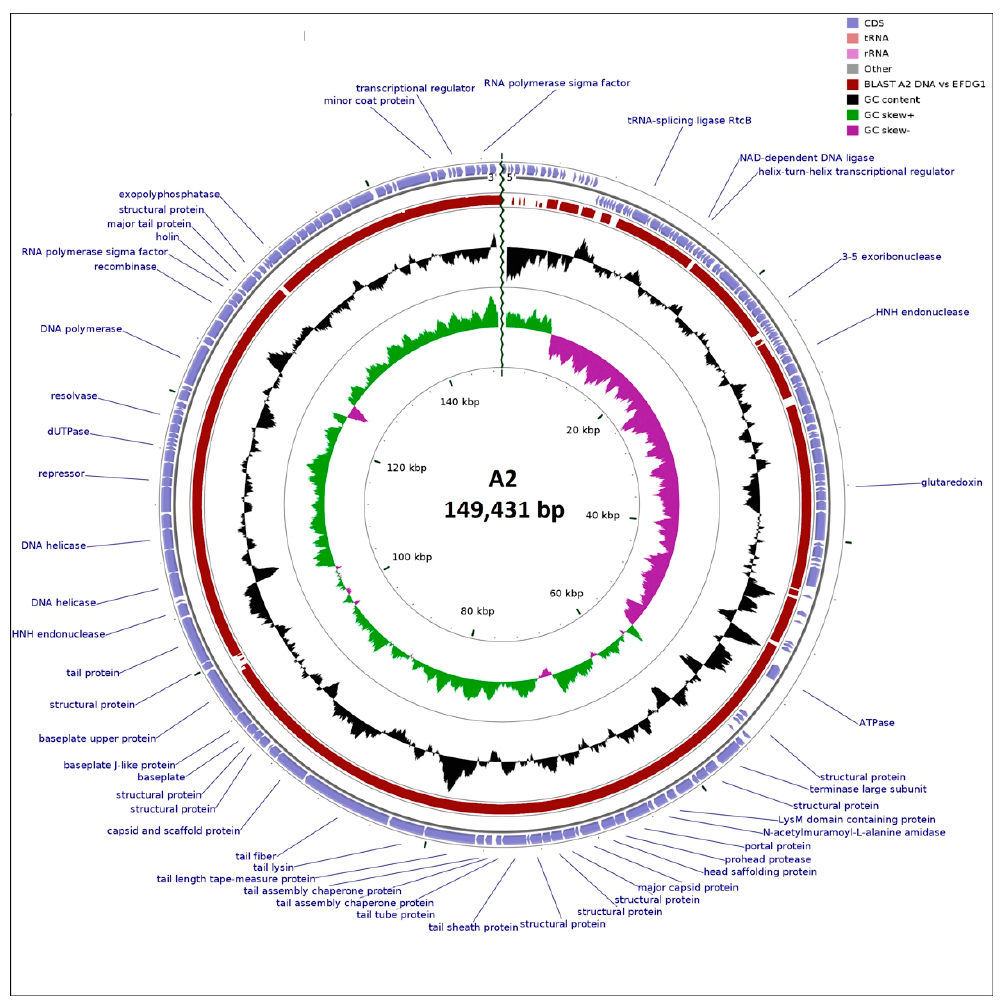
Figure 2. Summary of the genomic organization of Enterococcus phage A2. The outer ring shows putative ORFs, represented by purple arrowheads labelled with a predicted function where possible. The following inner ring shows a TBLASTX comparison (in red, where homologous) to Enterococcus phage EFDG1. GC content is depicted in black, while positive and negative GC skew is denoted by green and purple, respectively.